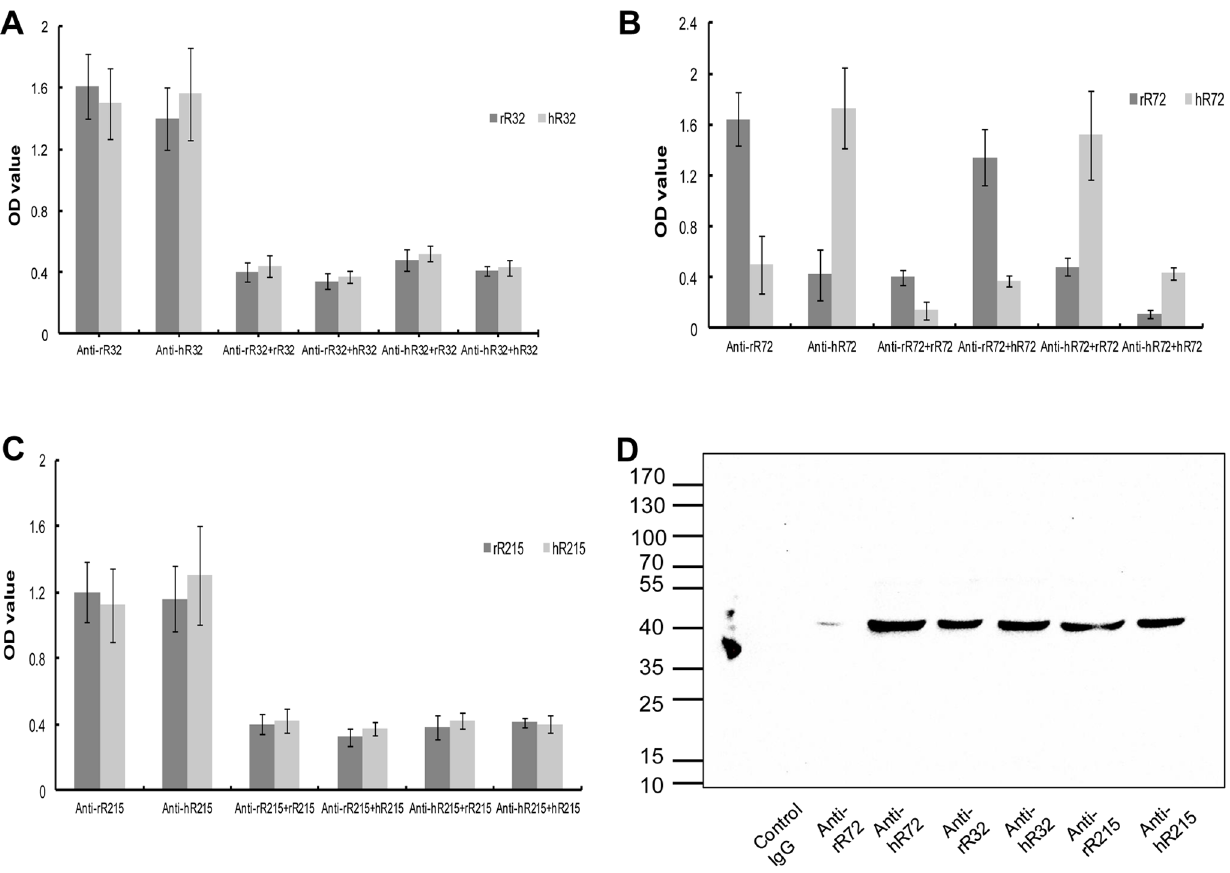
Figure 2. The cross-reactivity and specificity of the anti-peptides antibodies. A–C. The titers of the antisera against rat/human peptides were determined by an ELISA test in which plates were coated with the same sites human/rat peptides. Complete cross-reactivity of the anti-R32 and anti-R215 antibodies from rat and human sequences was confirmed, while the anti-R72 antibodies showed low cross-reactivity. D. The anti-peptides antibodies were used as primary antibodies, western blotting demonstrated that the anti-peptides antibodies specifically bound to renin. doi:10.1371/journal.pone.0066420.g002 (Table 2). In view of the deep position of the catalytic sites, the renin molecule may not extend its catalytic sites sufficiently in Table 2. Recognition of human renin by the anti-peptides ELISA plates. The l25 I-labeled recombinant human renin was further used to identify the binding of the antisera with renin. We found that the antisera against the peptides, except rR72, bound to renin with a 24–51% range at a final dilution of 1:2 (Table 2).